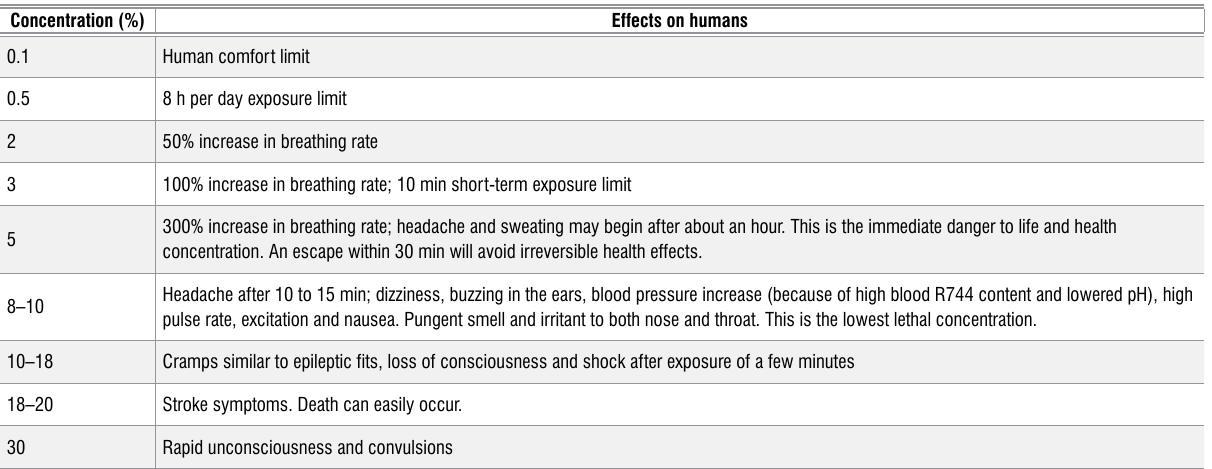
Concentration (%) Effects on humans 0.1 Human comfort